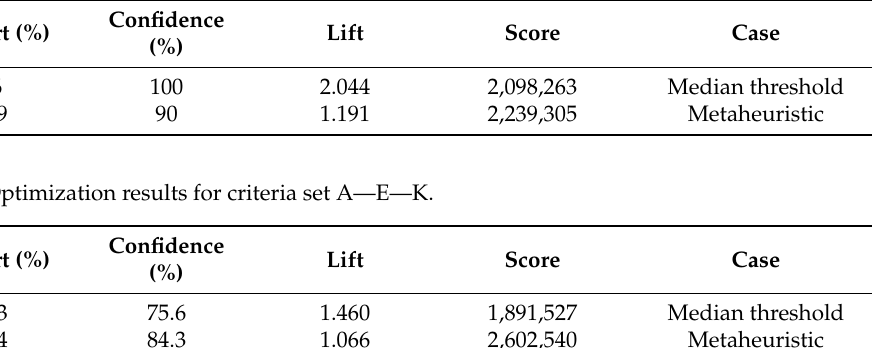
Table 4. Optimization results for criteria set Cr—E—J—L.